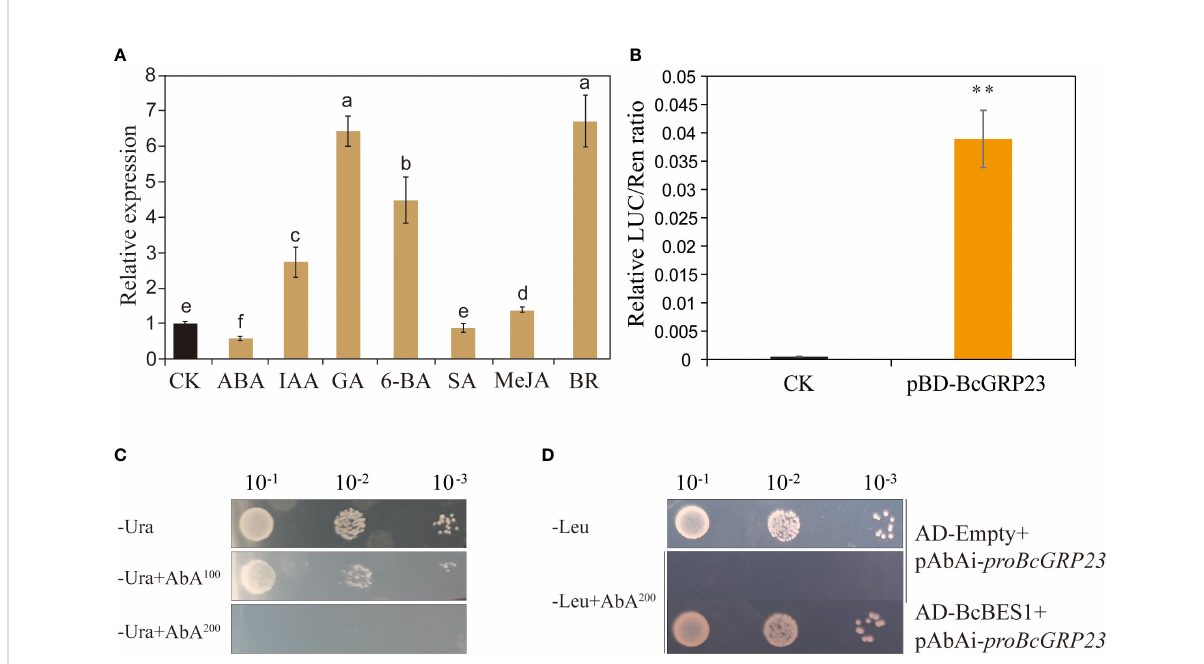
FIGURE 9 Analysis of the BES1 transcription factor that regulates BcGRP23 promoter activity. (A) Effects of different hormones on the expression of BcGRP23 in fl owering Chinese cabbage. Different lowercase letters indicate signi fi cant differences at the p < 0.05 level. (B) Luciferase (LUC)/ Renilla (REN) ratio indicating the relative luciferase activity in the dual-LUC assay. **Signi fi cant difference at the p < 0.01 level. (C, D) Yeast one- hybrid analysis. (C) Autoactivation of the BcGRP23 promoters was tested on synthetically de fi ned (SD) medium without Ura in the presence